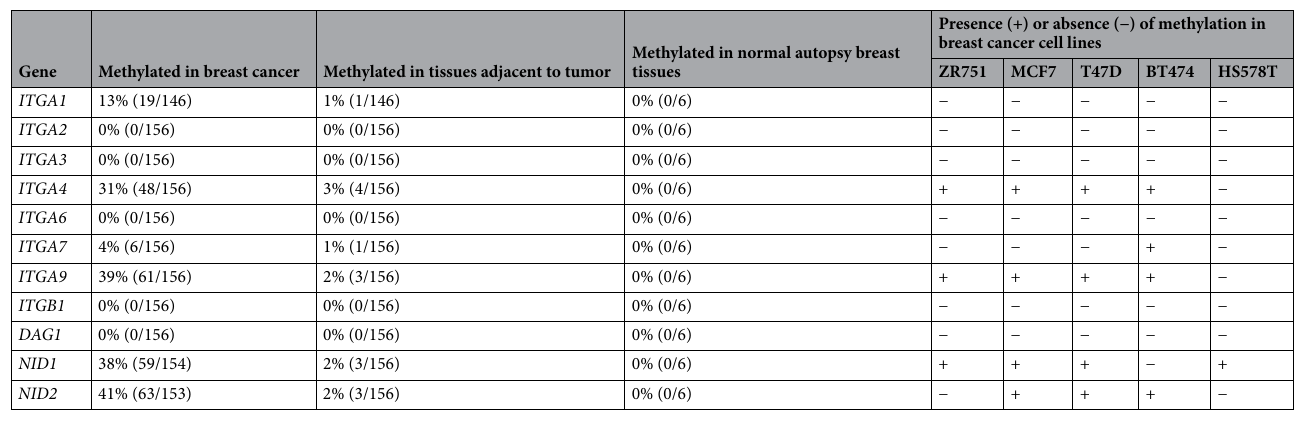
Table 1. Methylation status of integrin, nidogen, and dystroglycan CpG islands assessed by MSRE-PCR in breast tissues and cell